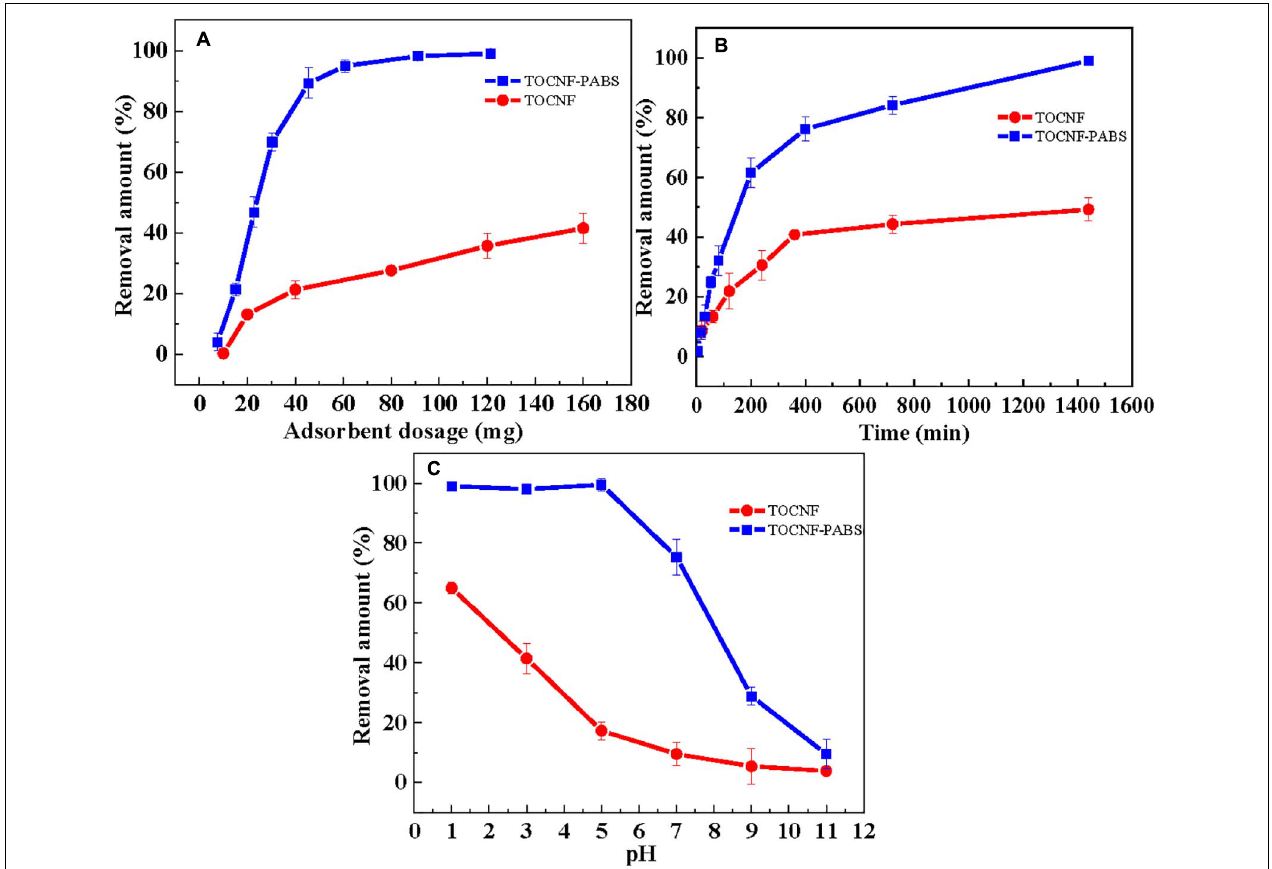
TABLE 2 | Characteristic parameters of Langmuir and Freundlich models for the adsorption of Cr(VI) onto TOCNF and TOCNF-PABS. Samples Langmuir isotherm Freundlich isotherm